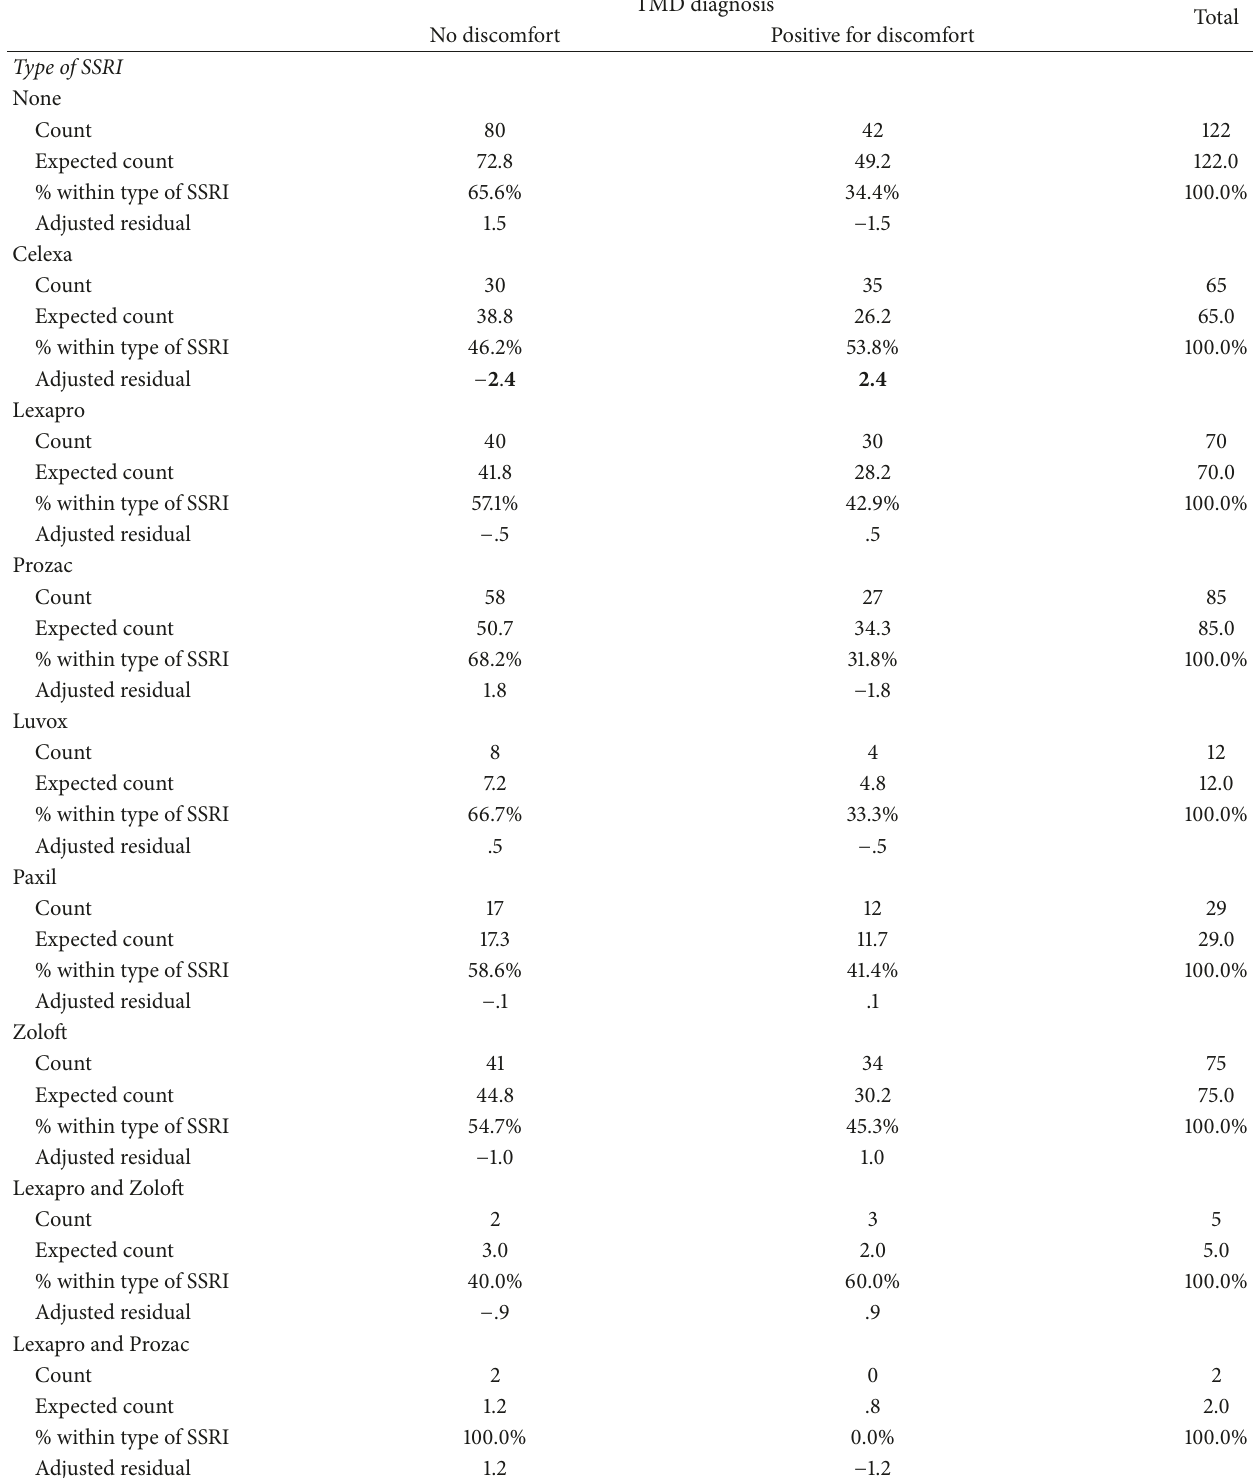
Table 2: Comparison of the type of SSRI medication by the presence of TMD symptoms. The results show that Celexa is the SSRI that is significantly different compared to the